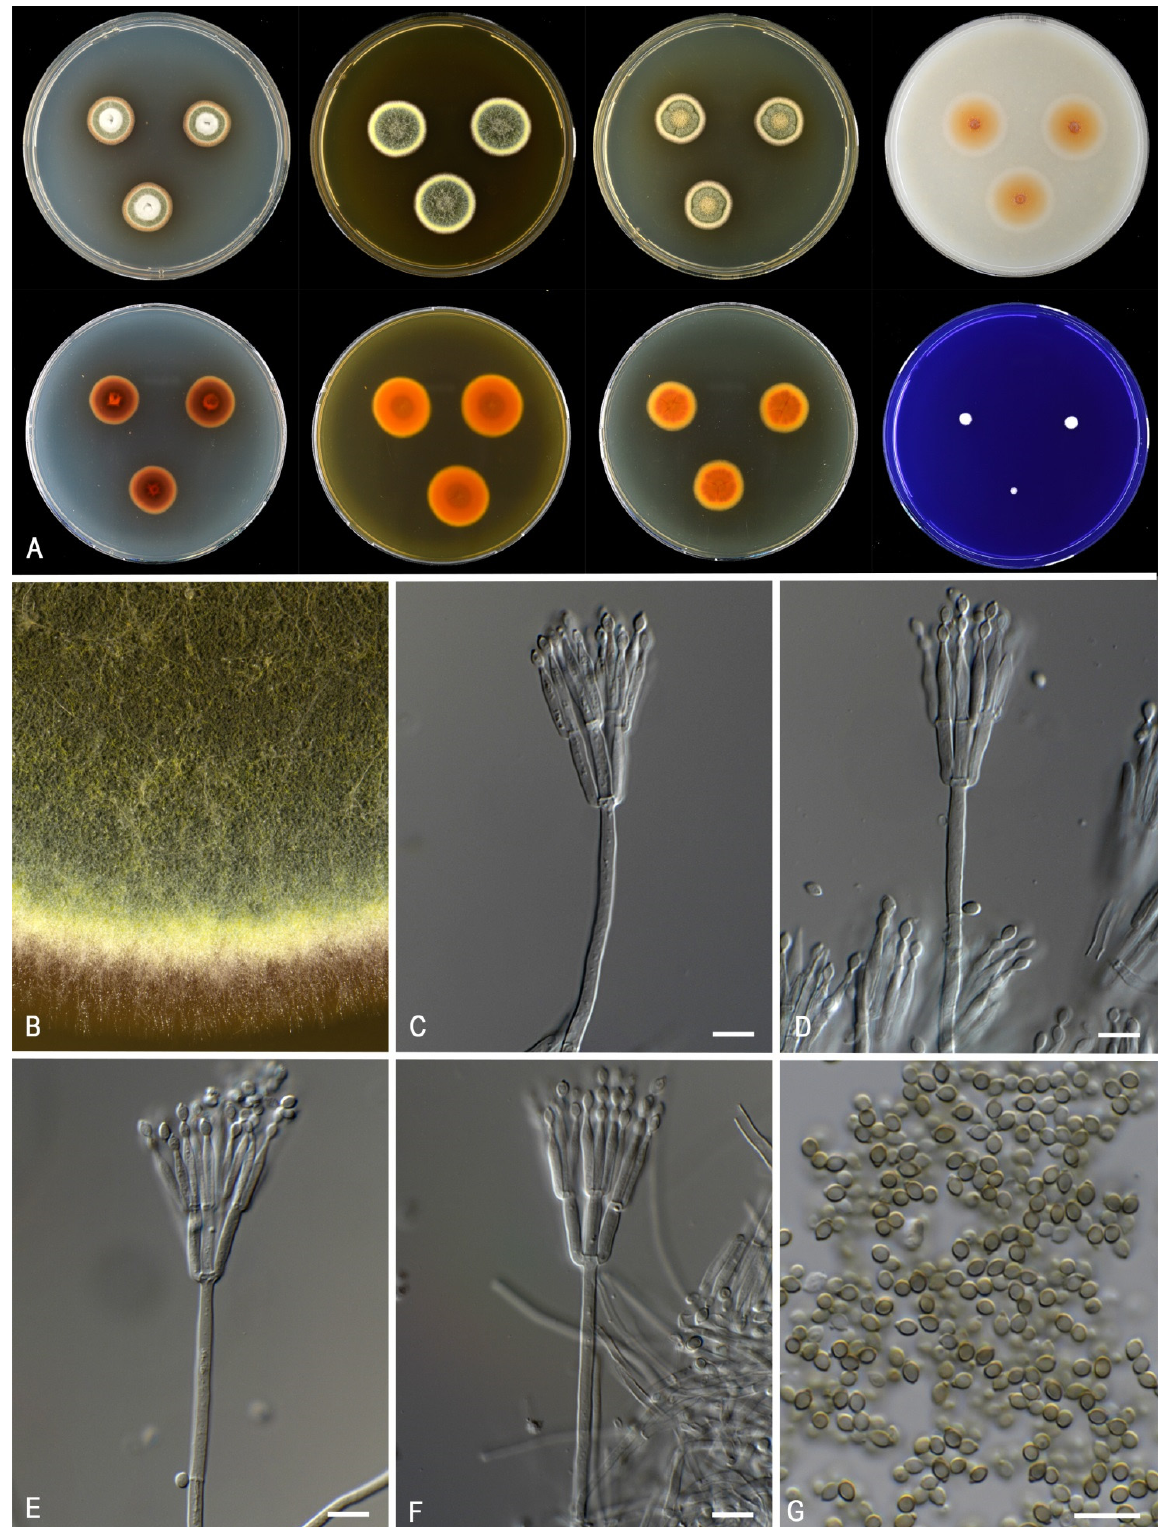
Figure 10. Morphological characters of Talaromyces minioluteus (CBS 642.68). ( A ). Colonies, from left to right, after 7 d at 25 °C (top row) CYA, MEA, YES, OA; (bottom row) CYA reverse, MEA reverse, YES reverse, CREA. ( B ). Detail of colony on MEA. ( C – F ). Conidiophores and conidia. ( G ). Conidia. Scale bars = 10 μ m.